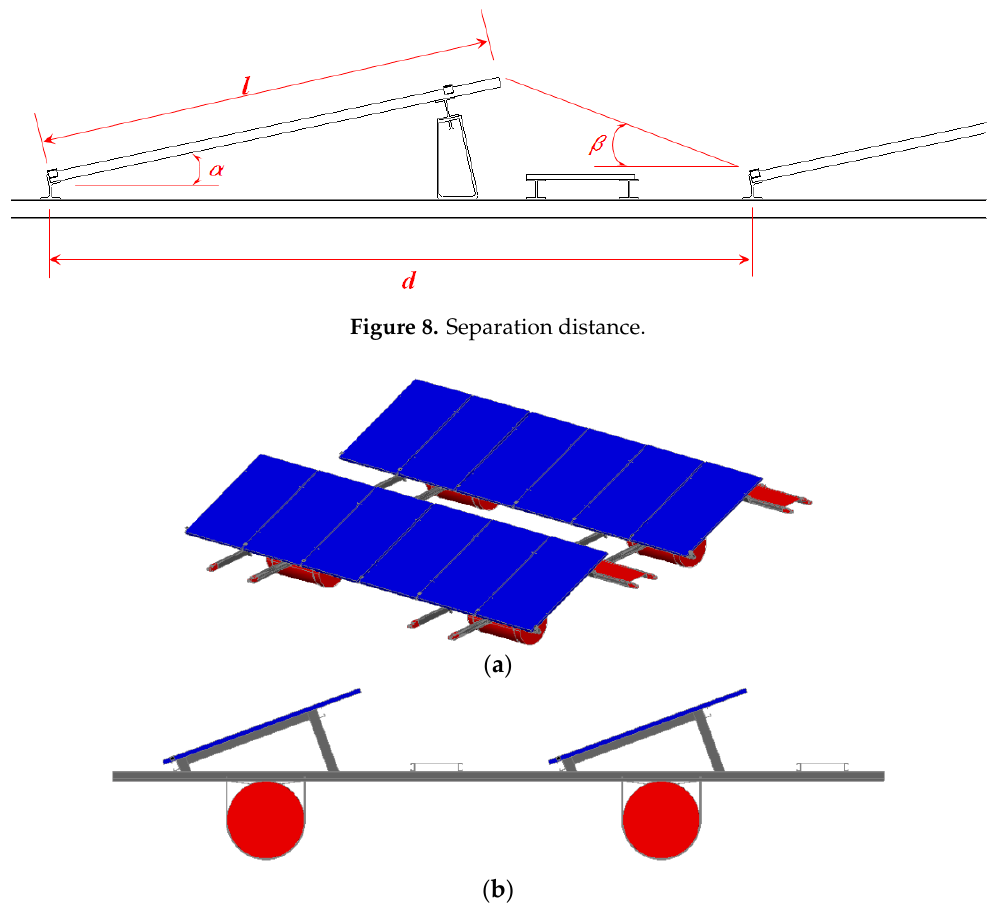
Figure 9. Floating photovoltaic system. ( a ) Unit module; ( b ) side view.